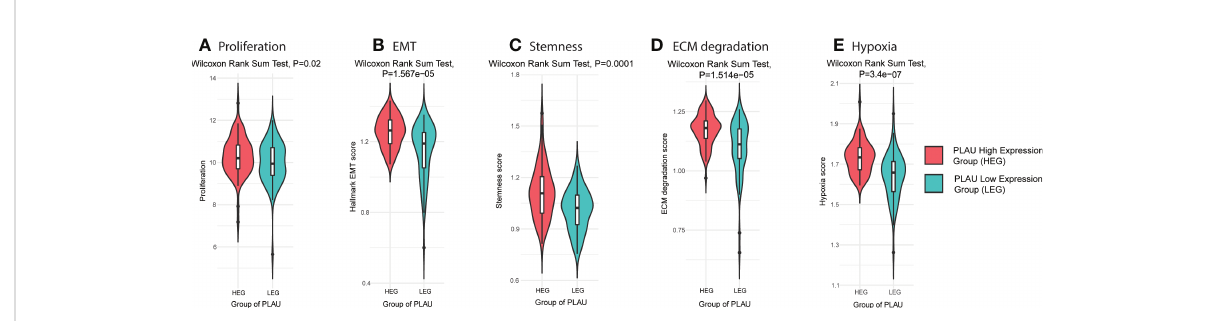
FIGURE 8 PLAU upregulation is associated with aggressive phenotypes of PDAC. Markers of an aggressive phenotype of PDAC were positively correlated with the high PLAU expressing group (HEG) compared to the low PLAU expression group (LEG), as depicted for (A) the tumour cell proliferation and growth index marker, MKI67, Wilcoxon rank-sum test, P= 0.02 (B) EMT Wilcoxon rank-sum test, P= 1.567e − 05, (C) tumour stemness, Wilcoxon Rank Sum Test, P=0.0001, (D) ECM degradation, Wilcoxon Rank Sum Test, P= 1.514e − 05 (D, E) hypoxia, Wilcoxon Rank Sum Test, P= 3.4e −